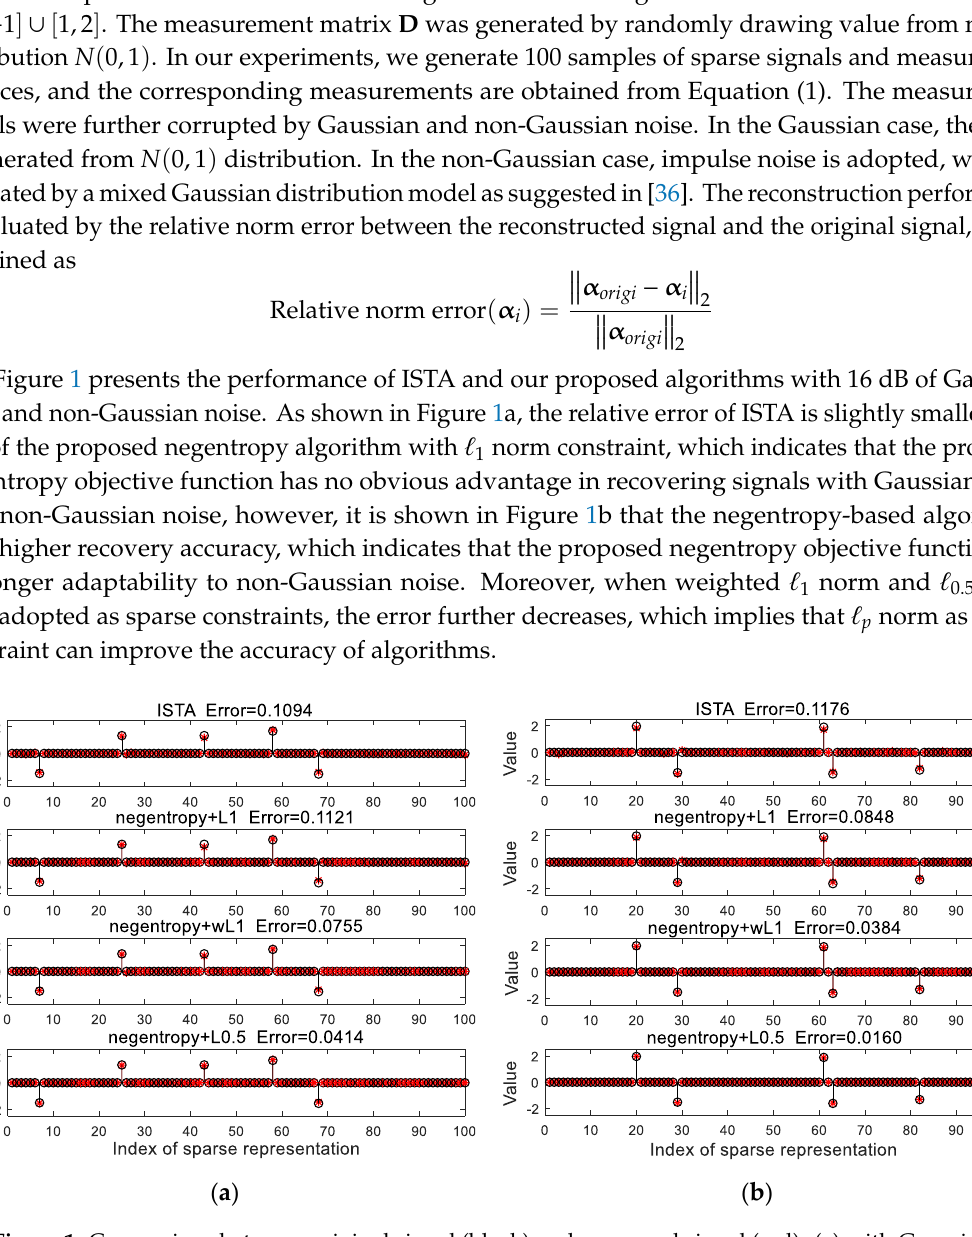
( b ) Figure 2. Relative norm error performance versus signal-to-noise ratio (SNR). ( a ) Comparison between ISTA and proposed algorithm with Gaussian noise; ( b ) comparison between ISTA and proposed algorithm with non-Gaussian noise. Figure 3 further illustrates the reconstruction performance with non-Gaussian noisy measurements under various compression ratios. As shown in Figure 3, as the compression ratio decreases, despite the performance of the algorithms deteriorating, the negentropy algorithm always maintains a lower relative